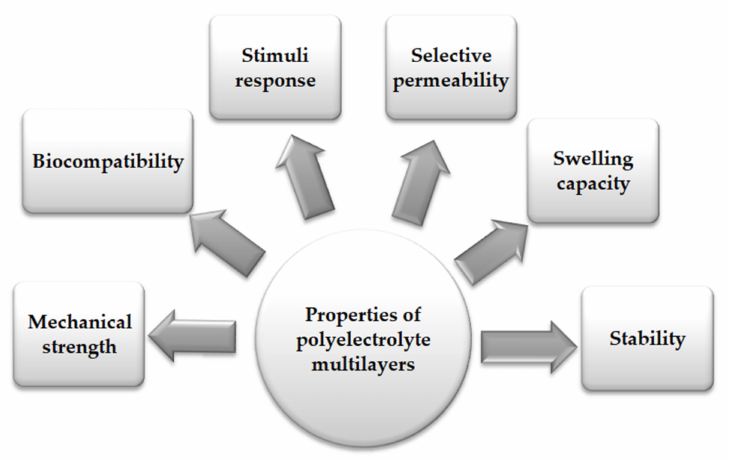
Figure 4. The main usually expected properties of polyelectrolyte